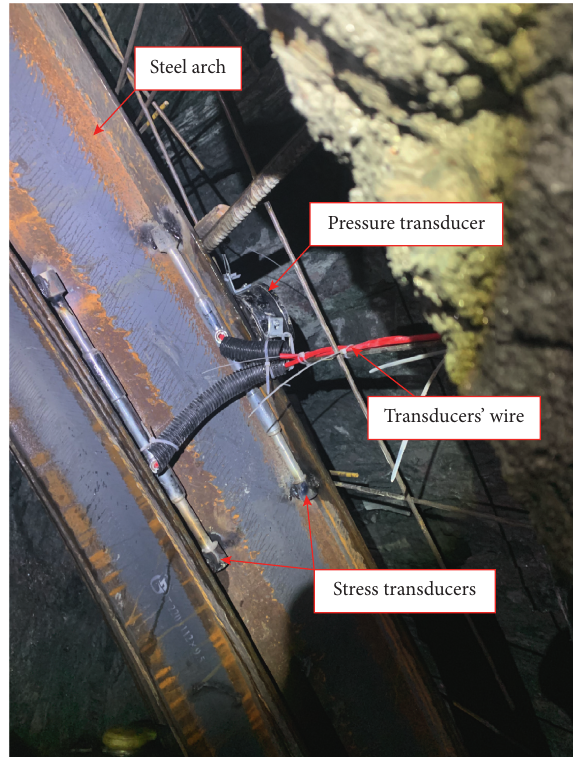
Figure 7: Locations of pressure and stress